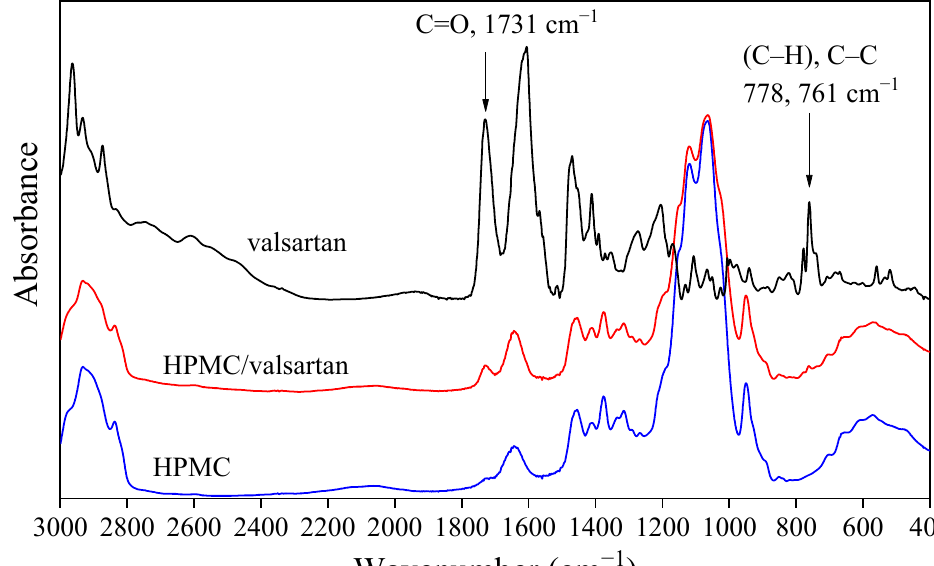
Figure 4. FTIR spectra recorded on valsartan, HPMC and electrospun HPMC fibers containing the drug at 20 wt%.